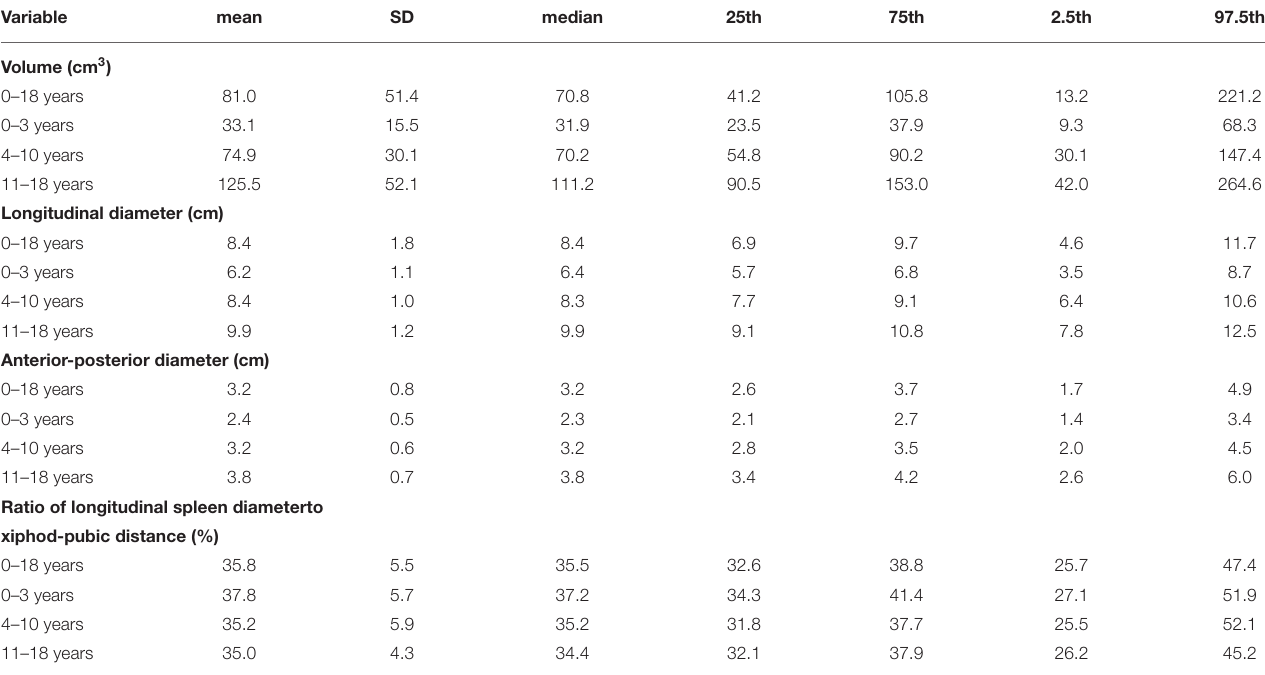
TABLE 2 | Age dependent variation of spleen size parameters (volume, diameters, ratio of longitudinal spleen diameter to xiphod-pubic distance) as determined by ultrasound evaluation in N = 317 healthy children and adolescents with normal body weight and height (3–97% percentile) of both sexes and of Caucasian origin [For details see